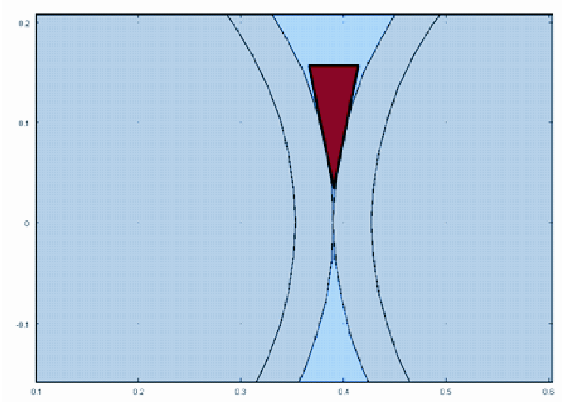
Figure 15. Visualization of the ionization zone and variable surface conductivity area.